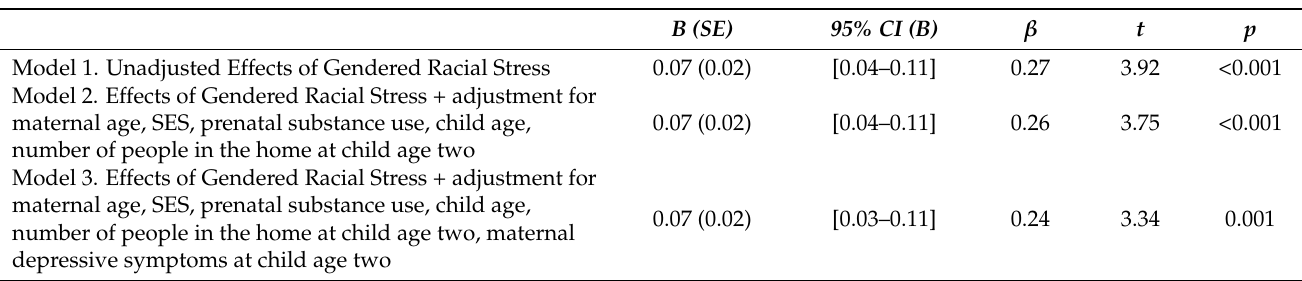
Table 4. Child sleep health at age two regressed on women’s experience of gendered racial stress ( N = 205). B (SE) 95% CI (B) β t p